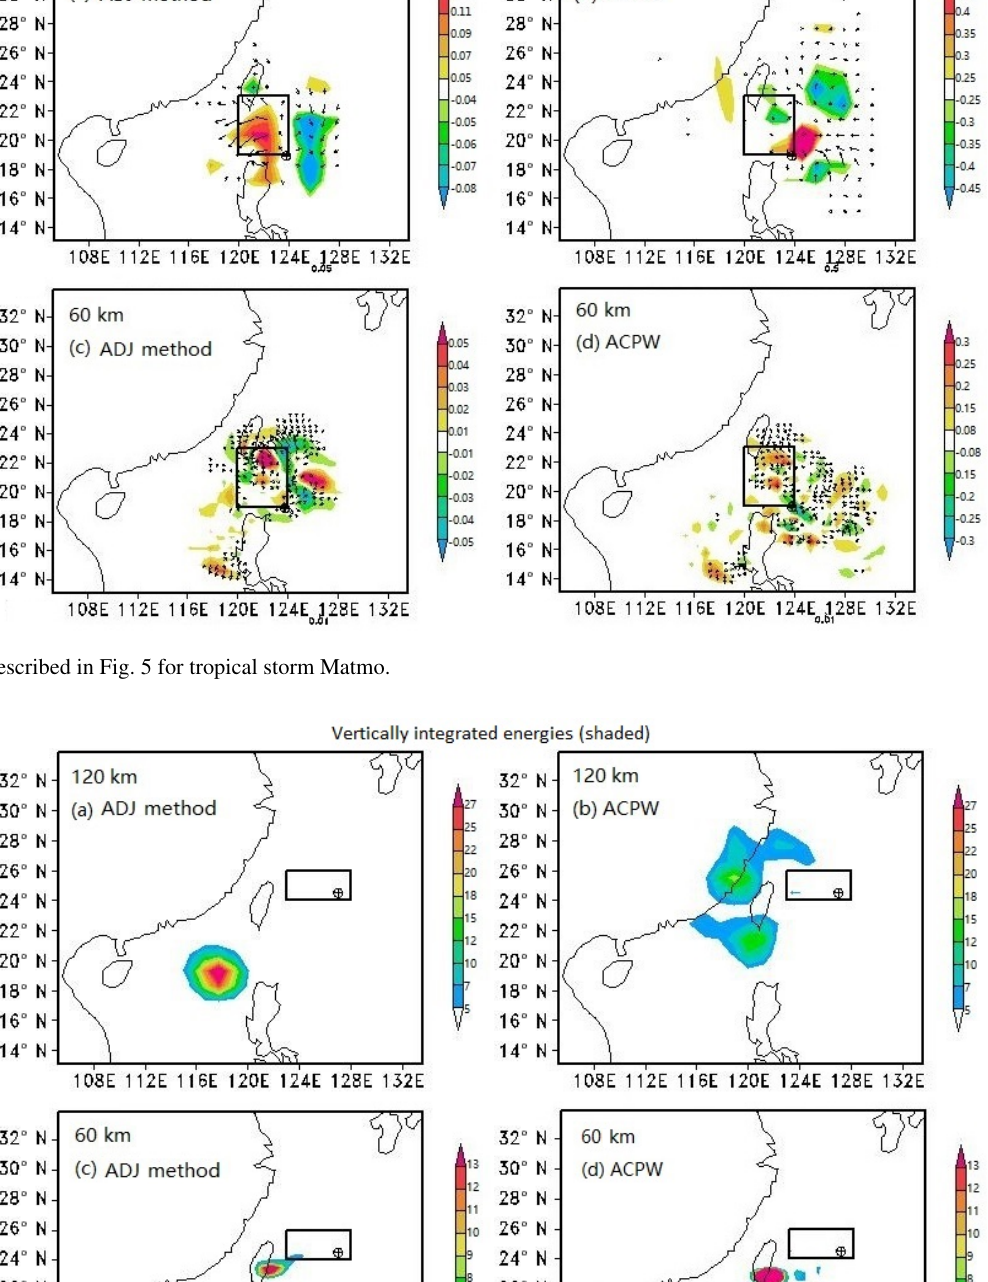
www.nonlin-processes-geophys.net/25/693/2018/ Nonlin. Processes Geophys., 25, 693–712,